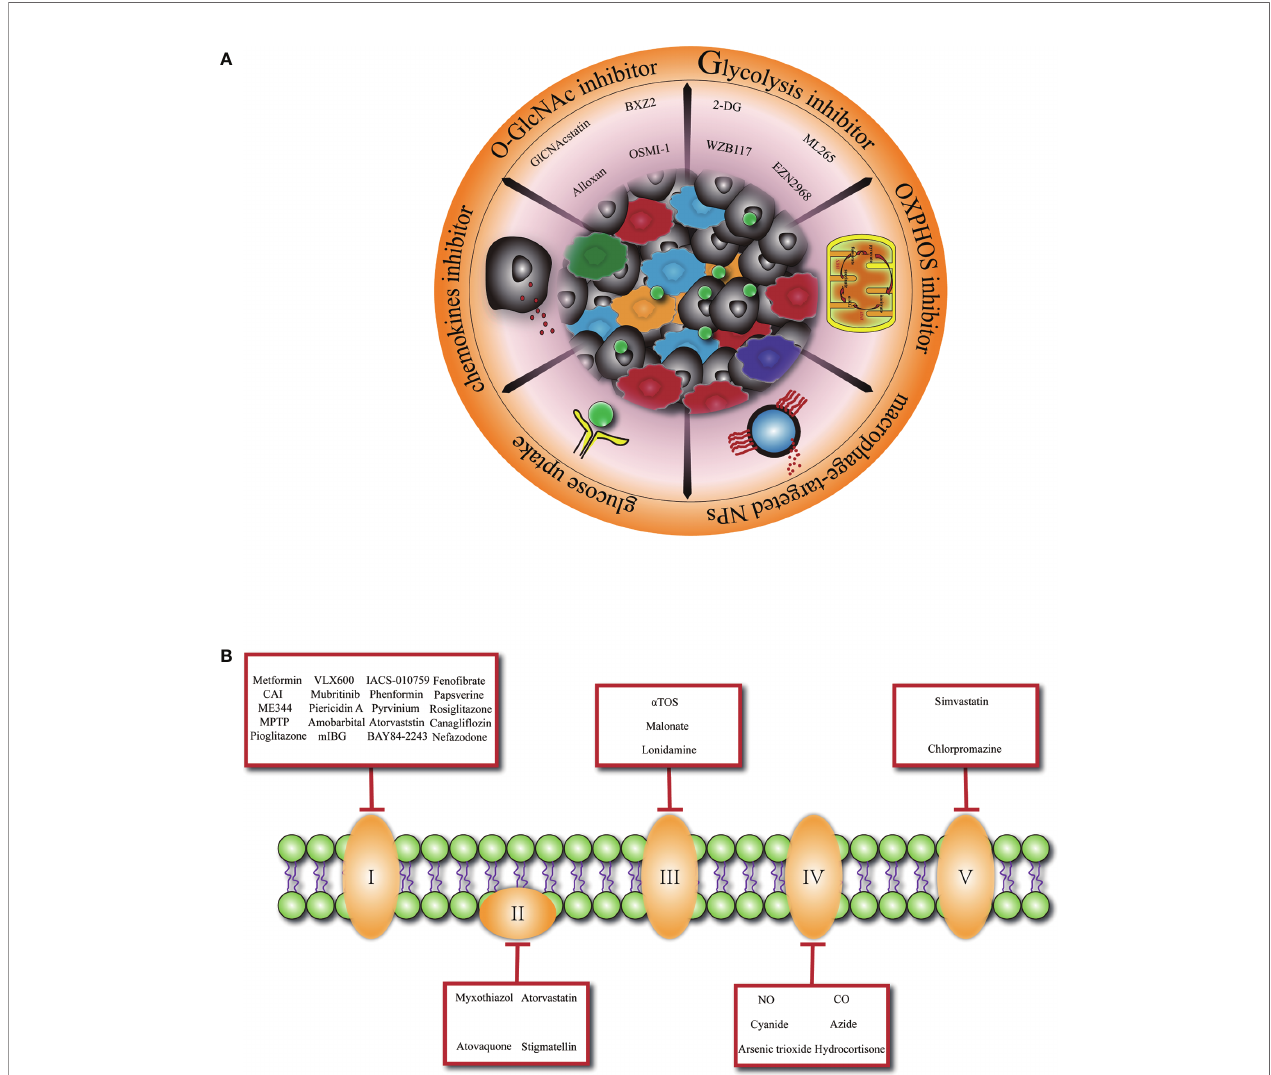
FIGURE 1 | Glucose metabolism basis macrophage-targeted therapy for cancer. (A) Overview of promising cancer therapy based on glucose metabolism characteristic in tumor-associated macrophage. 2-DG, 2-deoxyglucose. (B) Speci fi c presentation of OXPHOS (oxidative phosphorylation) inhibitors involved mitochondrial complex I, II, III, IV, V. CAI, carboxyamidotriazole; MPTP, 1-methyl 4-phenyl 1,2,3,6 tetrahydropyridine; mIBG2, meta-iodobenzylguanidine; aTOS, a- tocopheryl succinate; NO, nitric oxide; CO, carbon